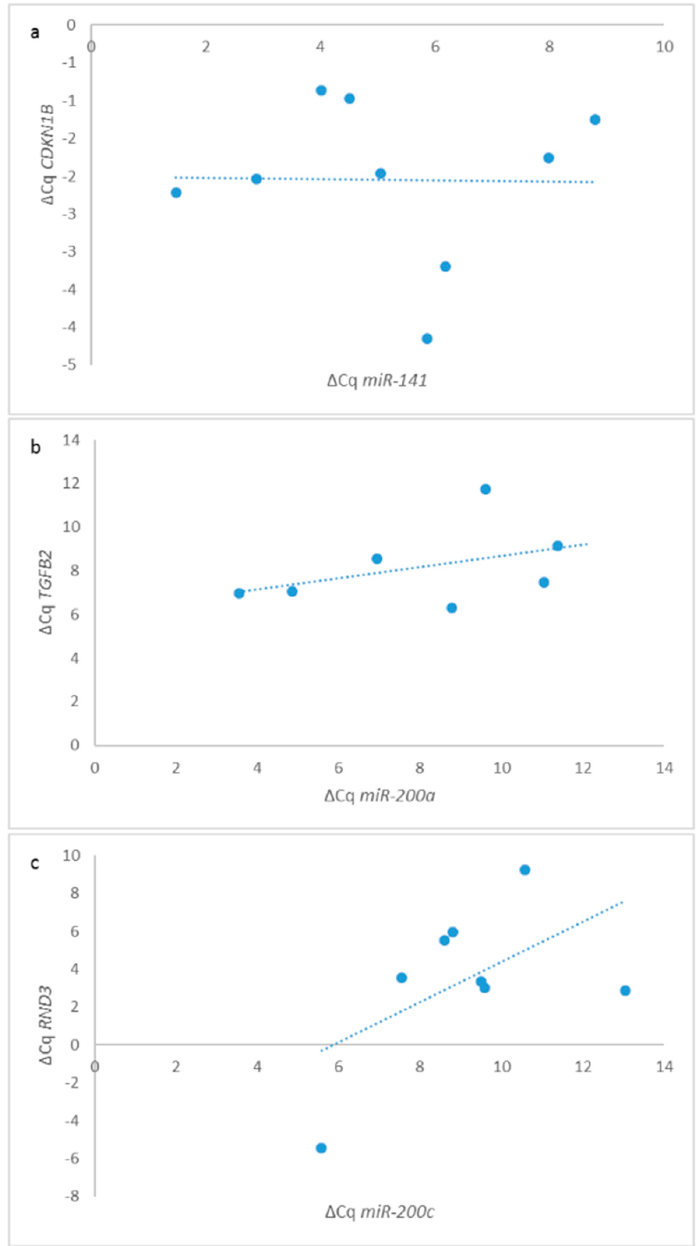
Figure 4. Correlations of expression of miR-200 family and their target genes in CRC N0 ( n = 10): ( a ) correlation between miR-141 and CDKN1B ; ( b ) correlation between miR-200a and TGFB2 ; ( c ) correlation between miR-200c and RND3 .